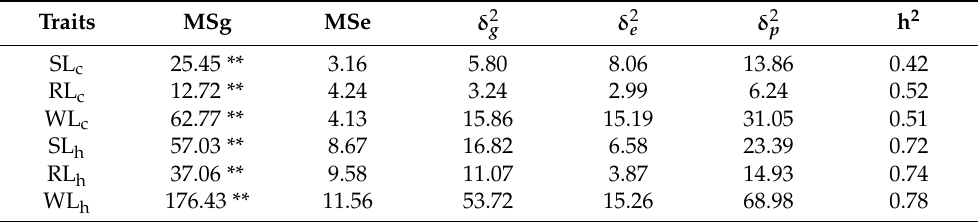
Table 1. Analysis of variance for heat tolerance associated traits and their heritability estimates in RILs.